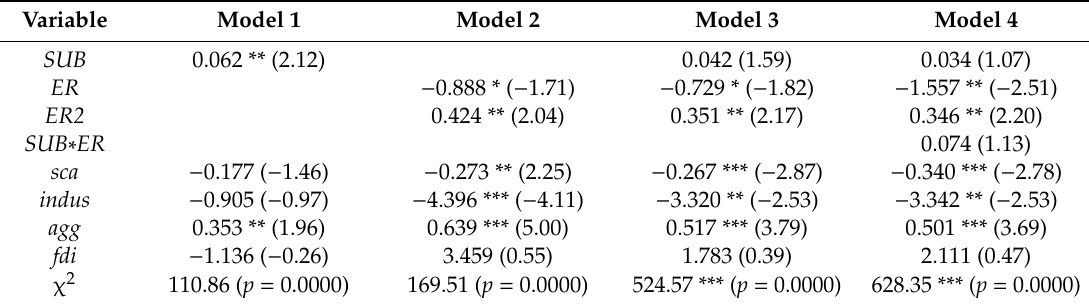
Table 5. Estimation results of the e ff ects of government R&D subsidies and environmental regulations on MGIE (from variable perspective).